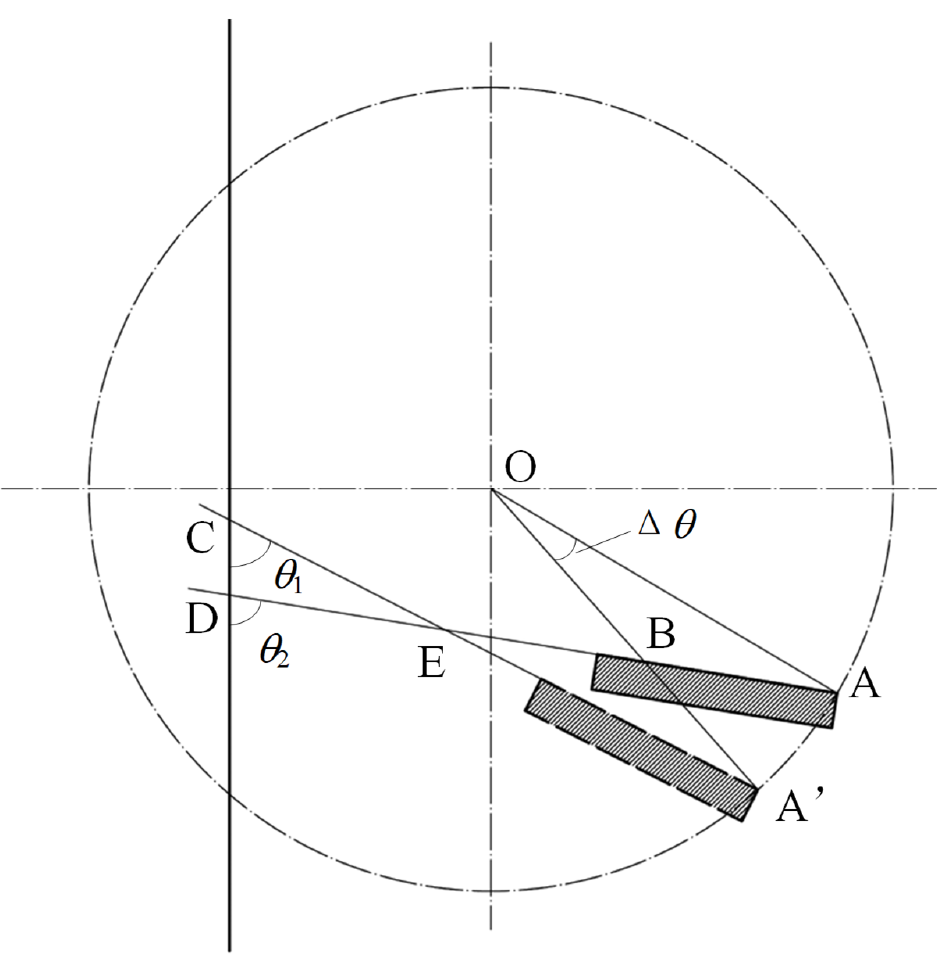
Figure 2. Schematic diagram of valve disc movement.